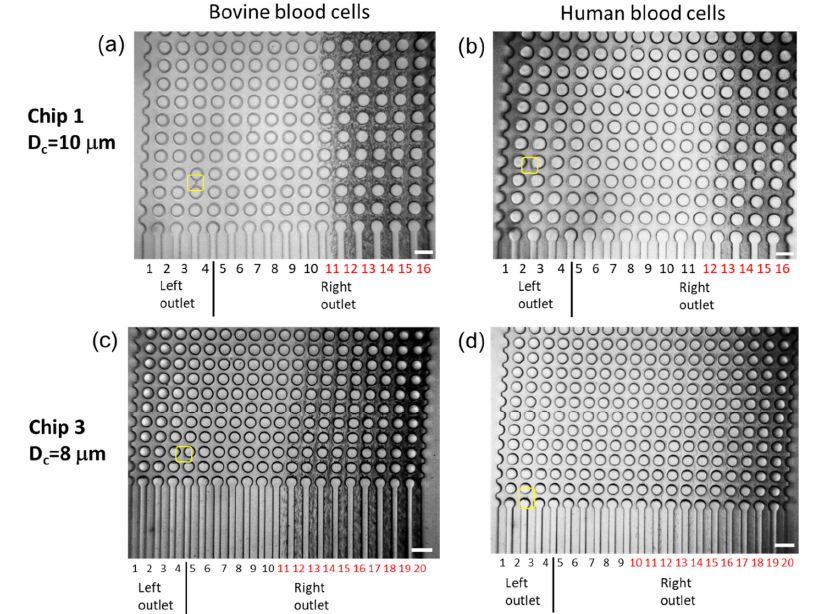
Figure 8. Images of bovine and human blood cell separations around outlet channels (one frame). ( a ) Bovine blood cells or ( b ) human blood cells separated using Chip 1 in which Channels 1–4 are connected to the left outlet and Channels 5–16 are connected to the right outlet. ( c ) Bovine blood cells or ( d ) human blood cells separated using Chip 3 in which Channels 1–4 are connected to the left outlet and Channels 5–20 are connected to the right outlet. The outlet channel number in red represents the observation of RBCs in the outlet channel. The particles in yellow squares are sorted into the left outlet. The scale bars are 100 µm.